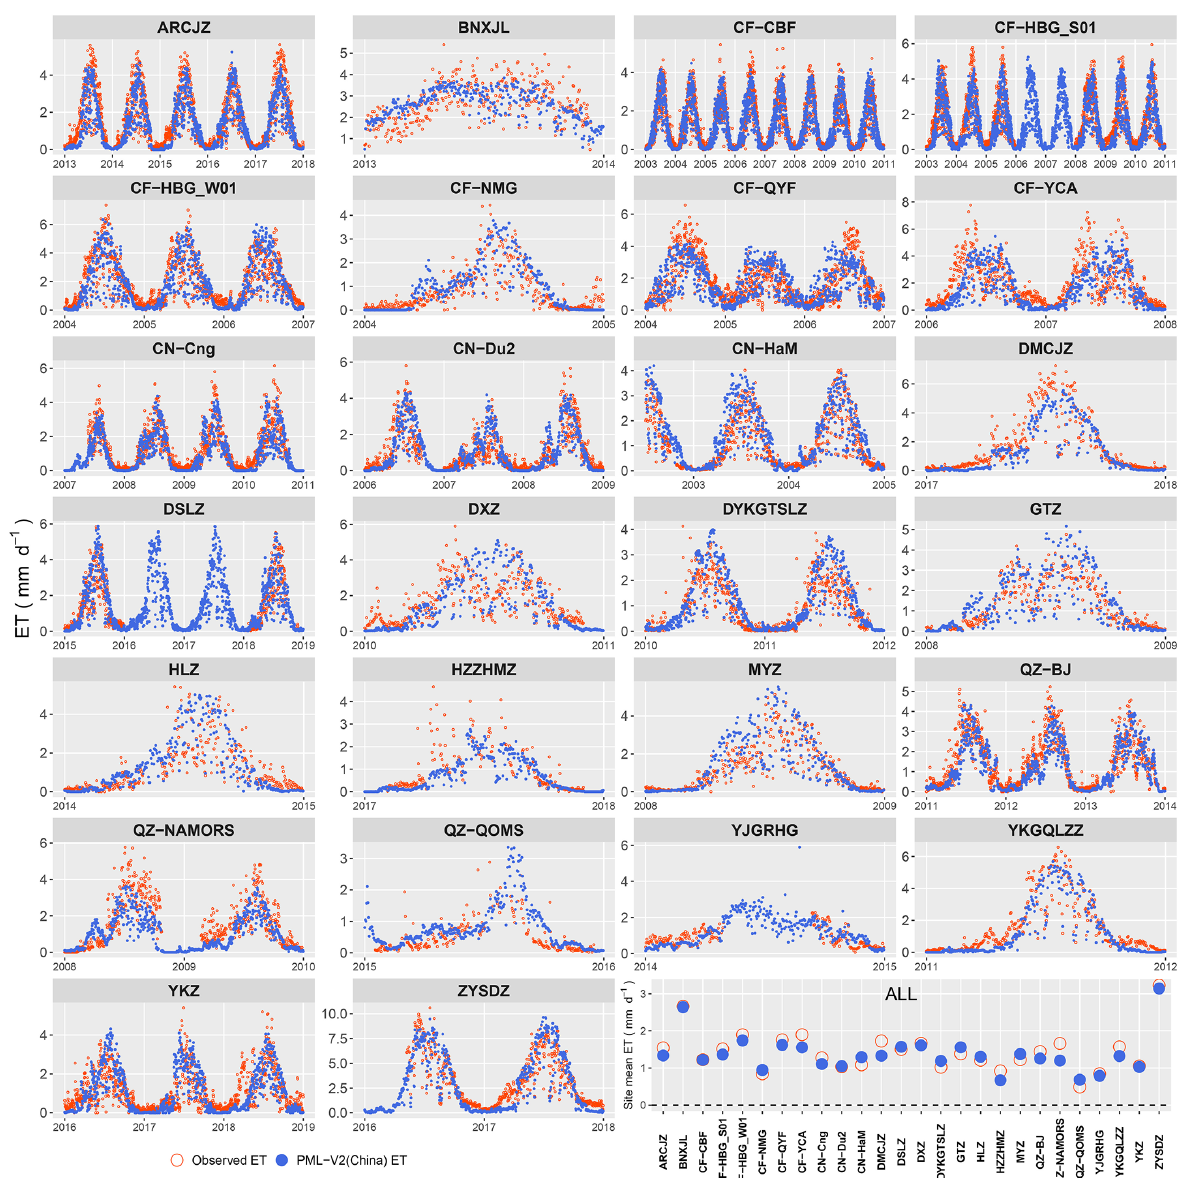
Figure 5. The daily ET simulated by PML-V2(China) in calibration mode and the observed daily ET variation in time series from 26 EC sites (see Fig. 2) across China. “ALL” represents the site mean value for each EC site.